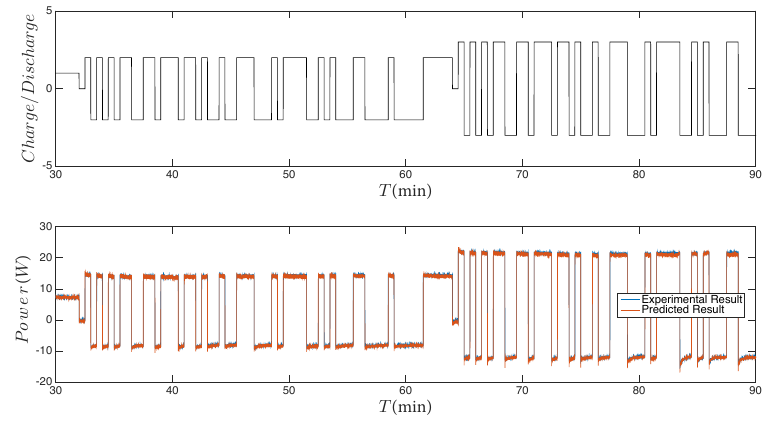
Figure 12. Validation results of dynamic power storage/delivery model with one-step-ahead power predictor ˆ p ( t | t − 1 ) in the last 60